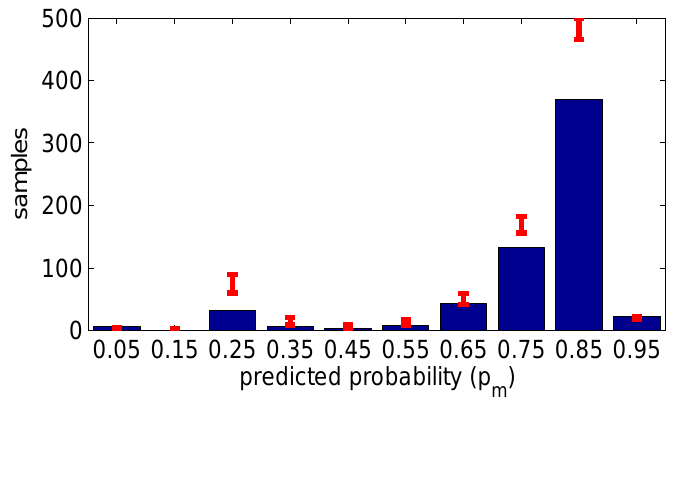
Figure 11. The number of samples (yes answers) at each bin centered at p from Binomial distribution